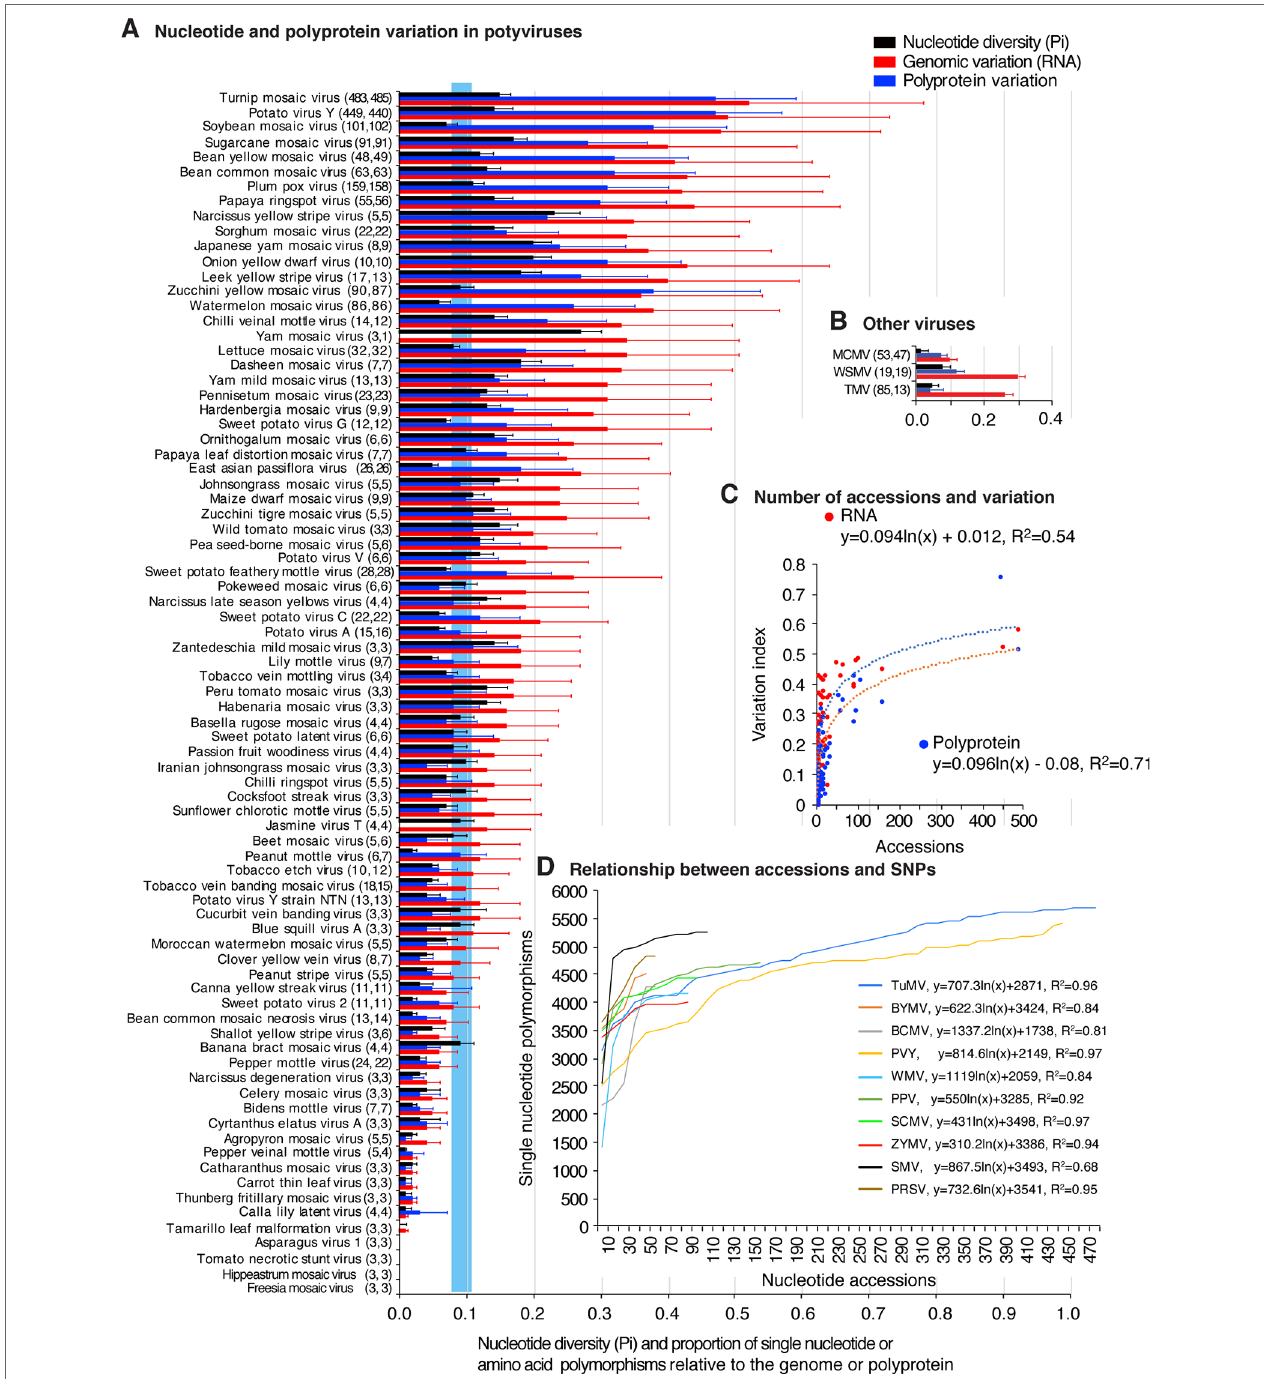
FiGUre 1 | Single nucleotide and amino acid polymorphism in potyviruses. Respect to the genome or polyprotein, bars represent the proportion of polymorphic sites (number of single nucleotide or amino acid polymorphism/length of the genome or polyprotein). For each species, the number of nucleotide and polyprotein accessions are indicated in parenthesis. Species with less than three accessions were not included. (A) Nucleotide and polyprotein variation in potyviruses, as determined by nucleotide diversity (Pi), genomic variation index and polyprotein variation index. Bars represent the average and standard error for each species and were estimated for the entire genome on a 50-nt or 50-amino acid interval. The blue vertical line represents the mean Pi and a 99% confidence interval for all potyviruses with detectable nucleotide variation. (B) Nucleotide and protein variation is three non-potyviruses used for comparison, maize chlorotic mottle virus (MCMV) genome and p111, wheat streak mosaic virus (WSMV) genome and polyprotein, and tobacco mosaic virus (TMV) genome and replicase protein. (c) Relationship between the number of sequence accessions available and nucleotide or polyprotein sequence variation. Variation and number of accession are as indicted in panel (A) . (D) Relationship between the number of sequence accessions and number of SNPs for the top 10 viruses with the most variation. Accessions available were processed in increments of 10. Parameters of a regression line are indicated for each